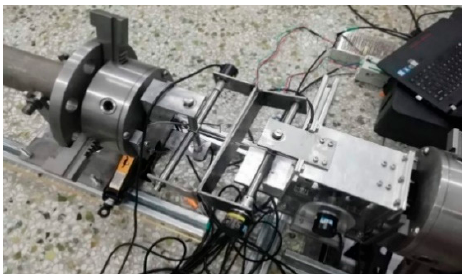
Figure 10. Initialization of measuring device based on flange center positioning.